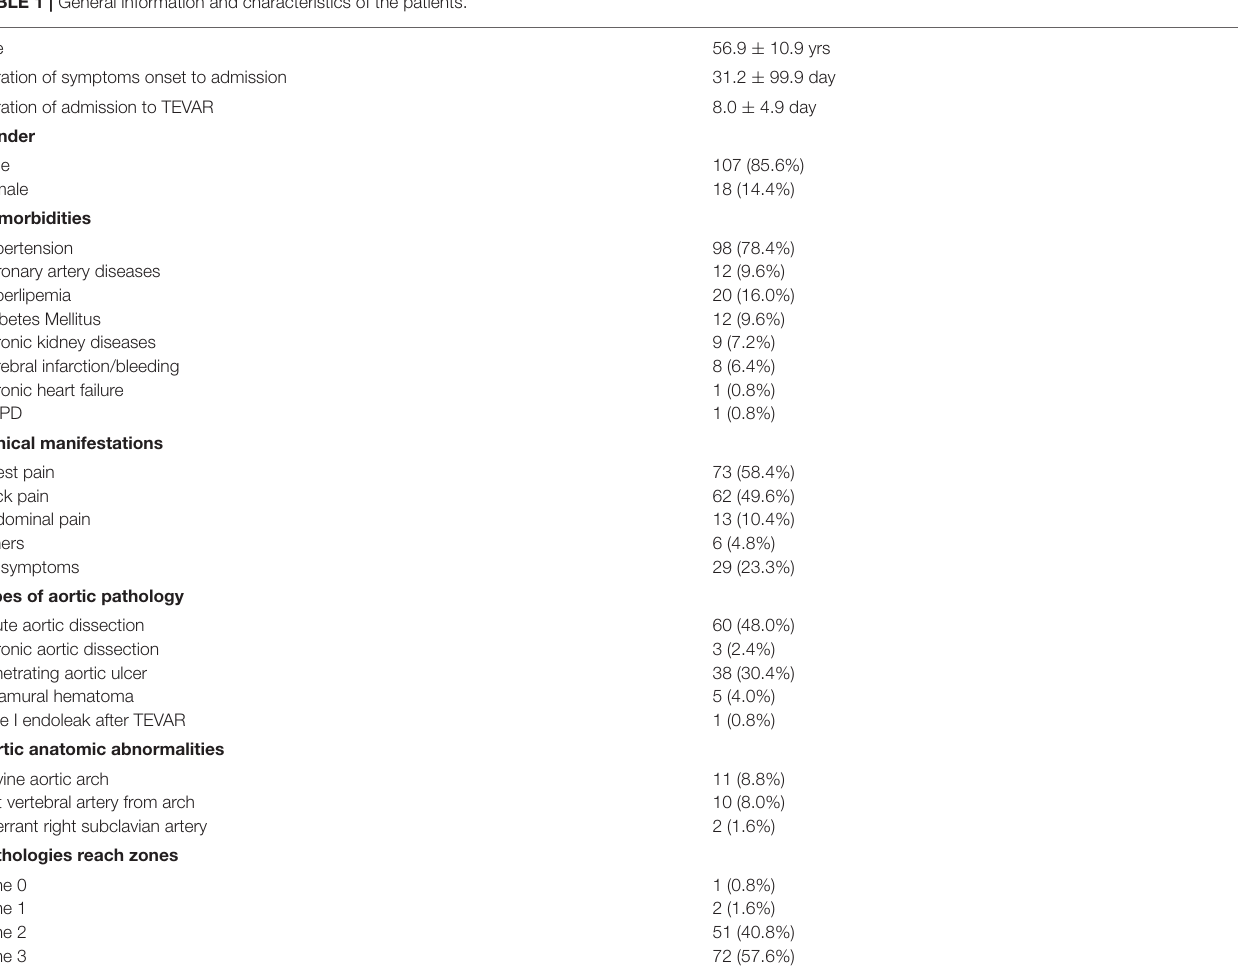
TABLE 1 | General information and characteristics of the